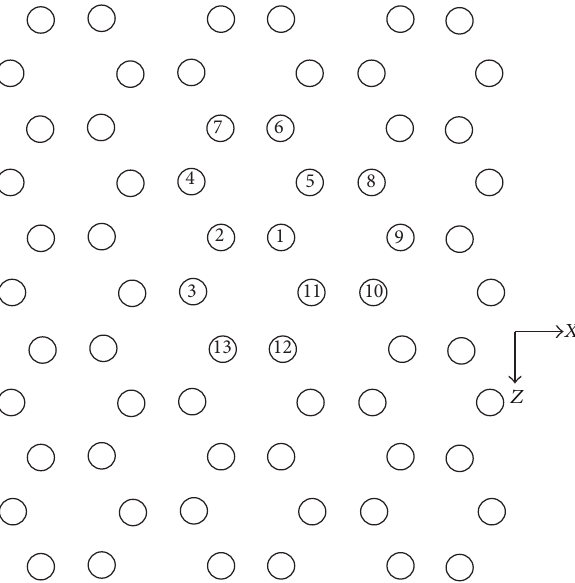
Figure 13: Resonant cavity model of the two-dimensional PBGS made by GaAs pillars in air with graphite lattice. The 𝑛 cavity is put forward as No. 1 to No. 𝑛 pillars